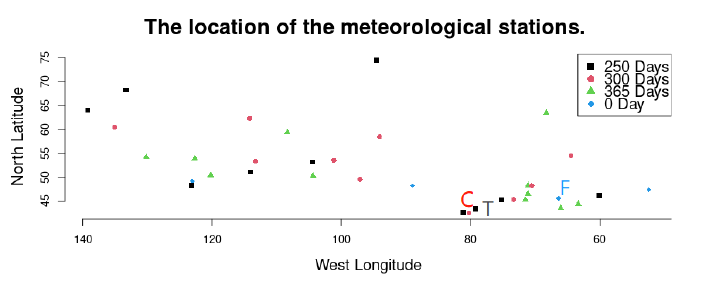
Figure 7. The location of 35 weather stations. C, T, and F represent the locations of Charlottetown, Toronto, and Fredericton, respectively.